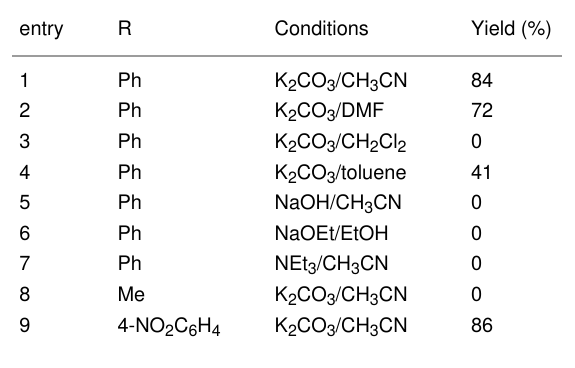
Table 1: Optimization of the reaction conditions for the preparation of compound 8a